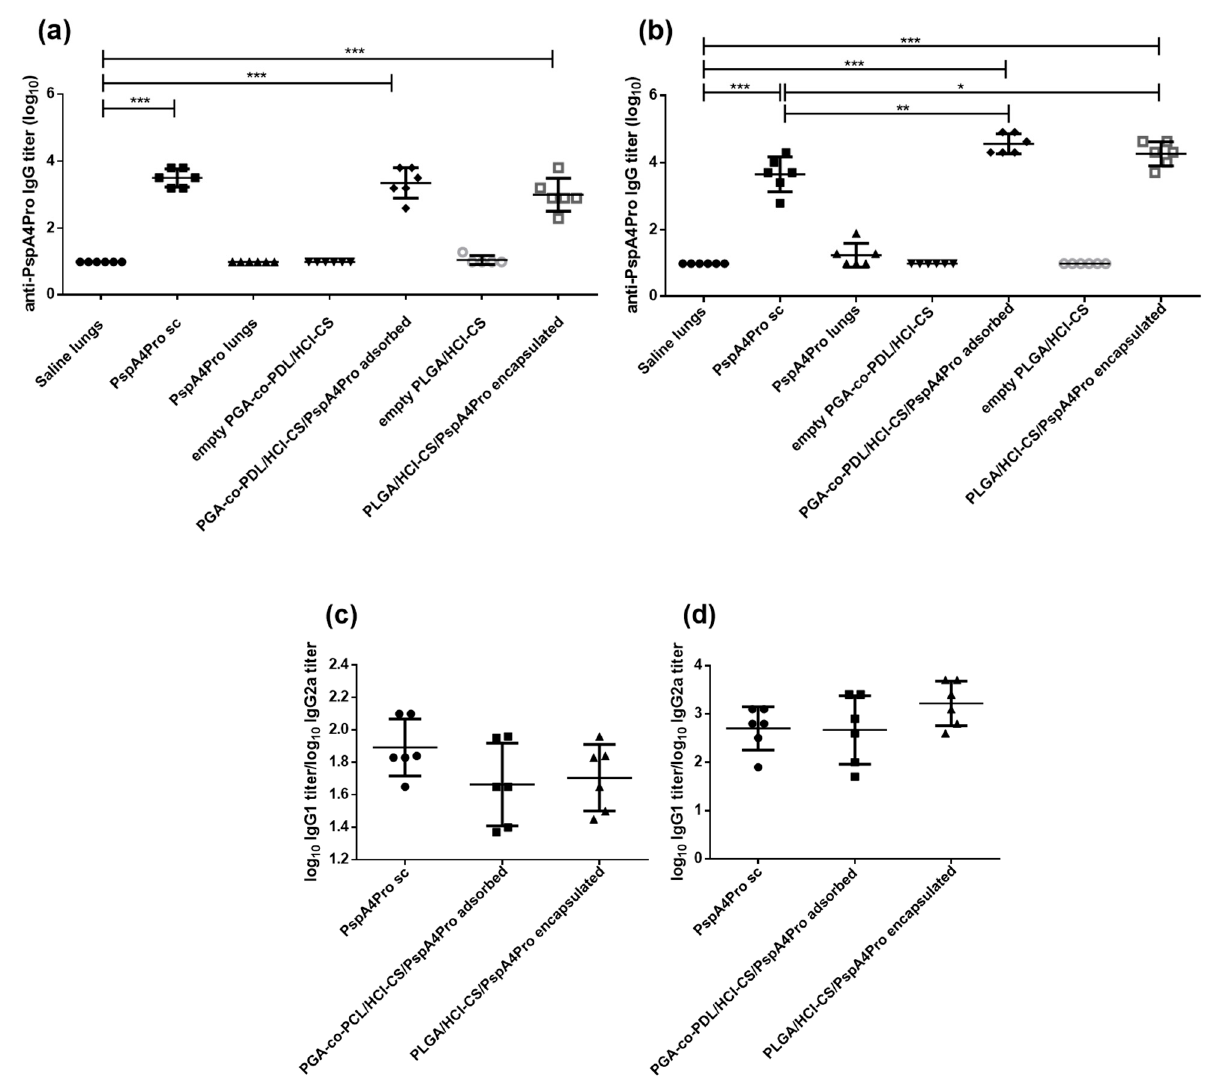
Figure 8. Induction of serum anti-PspA4Pro IgG antibodies by mucosal immunization targeting the lungs. Anti-PspA4Pro IgG antibodies in sera from mice inoculated with 2 doses of the indicated formulations containing 2 µ g PspA4Pro ( a , c ) or 6 µ g PspA4Pro ( b , d ) was determined by ELISA. Positive control mice were inoculated sc with PspA4Pro. Log 10 anti-PspA4Pro IgG titers ( a , b ) and log 10 anti-PspA4Pro IgG1 titer/log 10 anti-PspA4Pro IgG2a titer ratios ( c , d ) are shown. Symbols represent each individual. Means ± standard errors are shown. Significant statistically differences are indicated (One-way ANOVA, Tukey’s multicomparison test for a , b ; unpaired t -test for c , d ). * p < 0.05, ** p < 0.01, *** p < 0.001.